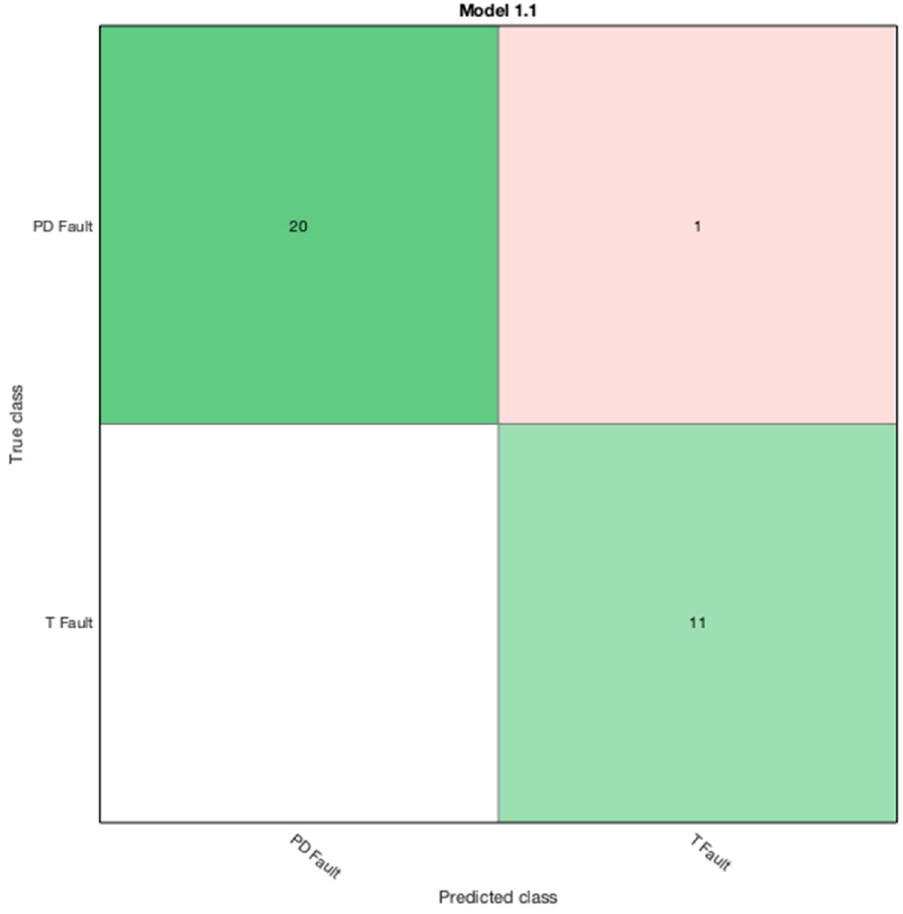
Figure 10. Confusion matrix for SVM 2 classifier.